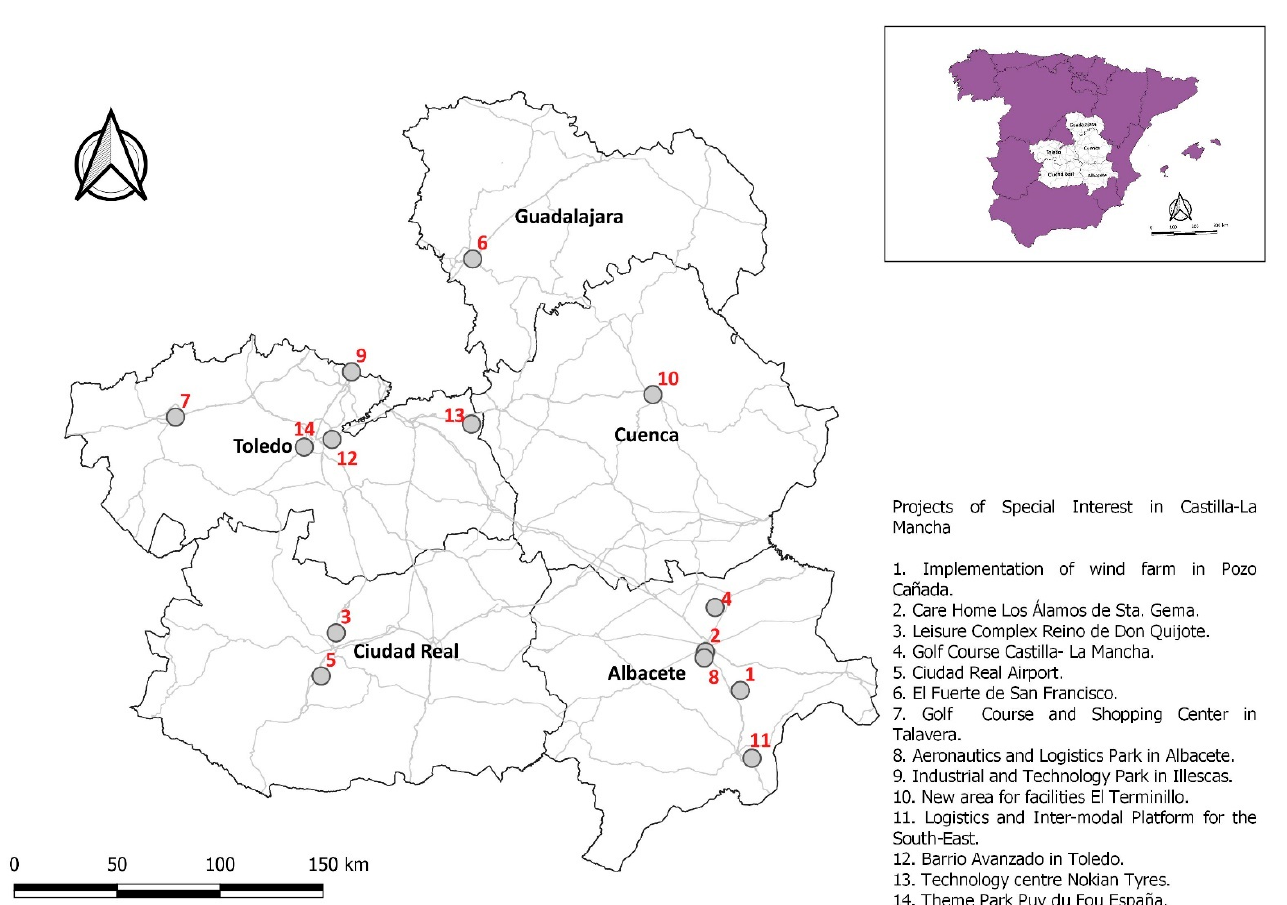
Figure 1. Projects of Special Interest in Castilla–La Mancha. Source: Regional Government of Castilla–La Mancha [4] and own preparation.